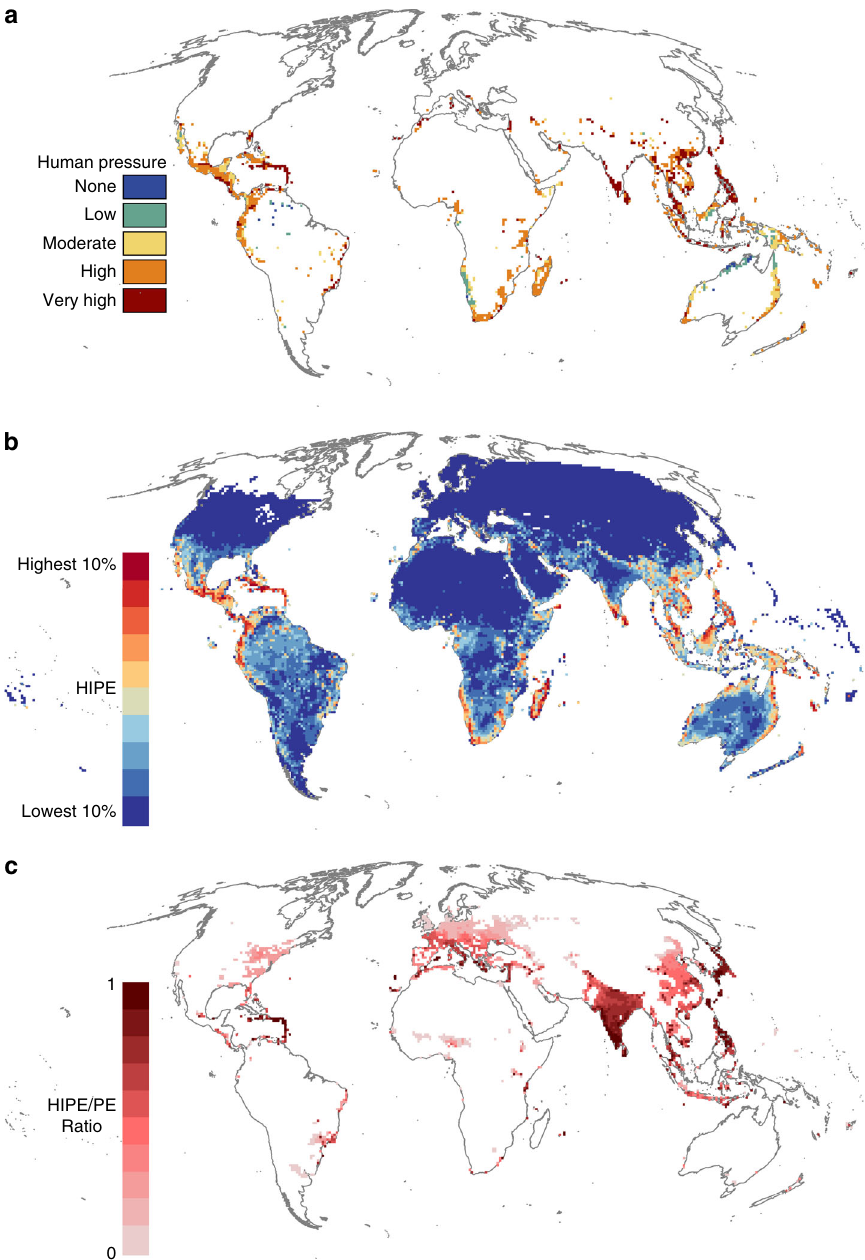
Fig. 3 Global patterns of reptilian phylogenetic endemism (PE) and human pressure. a regions of high reptilian PE (richest 10% of grid cells) and the level of human pressure in each grid cell. b Global patterns of reptilian human-impacted phylogenetic endemism (HIPE), where grid cells are coloured by the cumulative amount of global HIPE captured; darkest red cells comprise the highest-scoring grid cells which together capture 10% of global HIPE, whereas the lowest-scoring grid cells which together capture 10% of global HIPE are coloured dark blue. c ratio of HIPE to PE for grid cells under very high human pressure (HF ≥ 12). Given that we only show cells of very high human pressure, a ratio of 1:1 (darkest red) means all PD found in the grid cell is restricted to regions of very high human pressure, and the lower this becomes (increasingly lighter reds), the greater the proportion of phylogenetic diversity also distributed in regions with less human